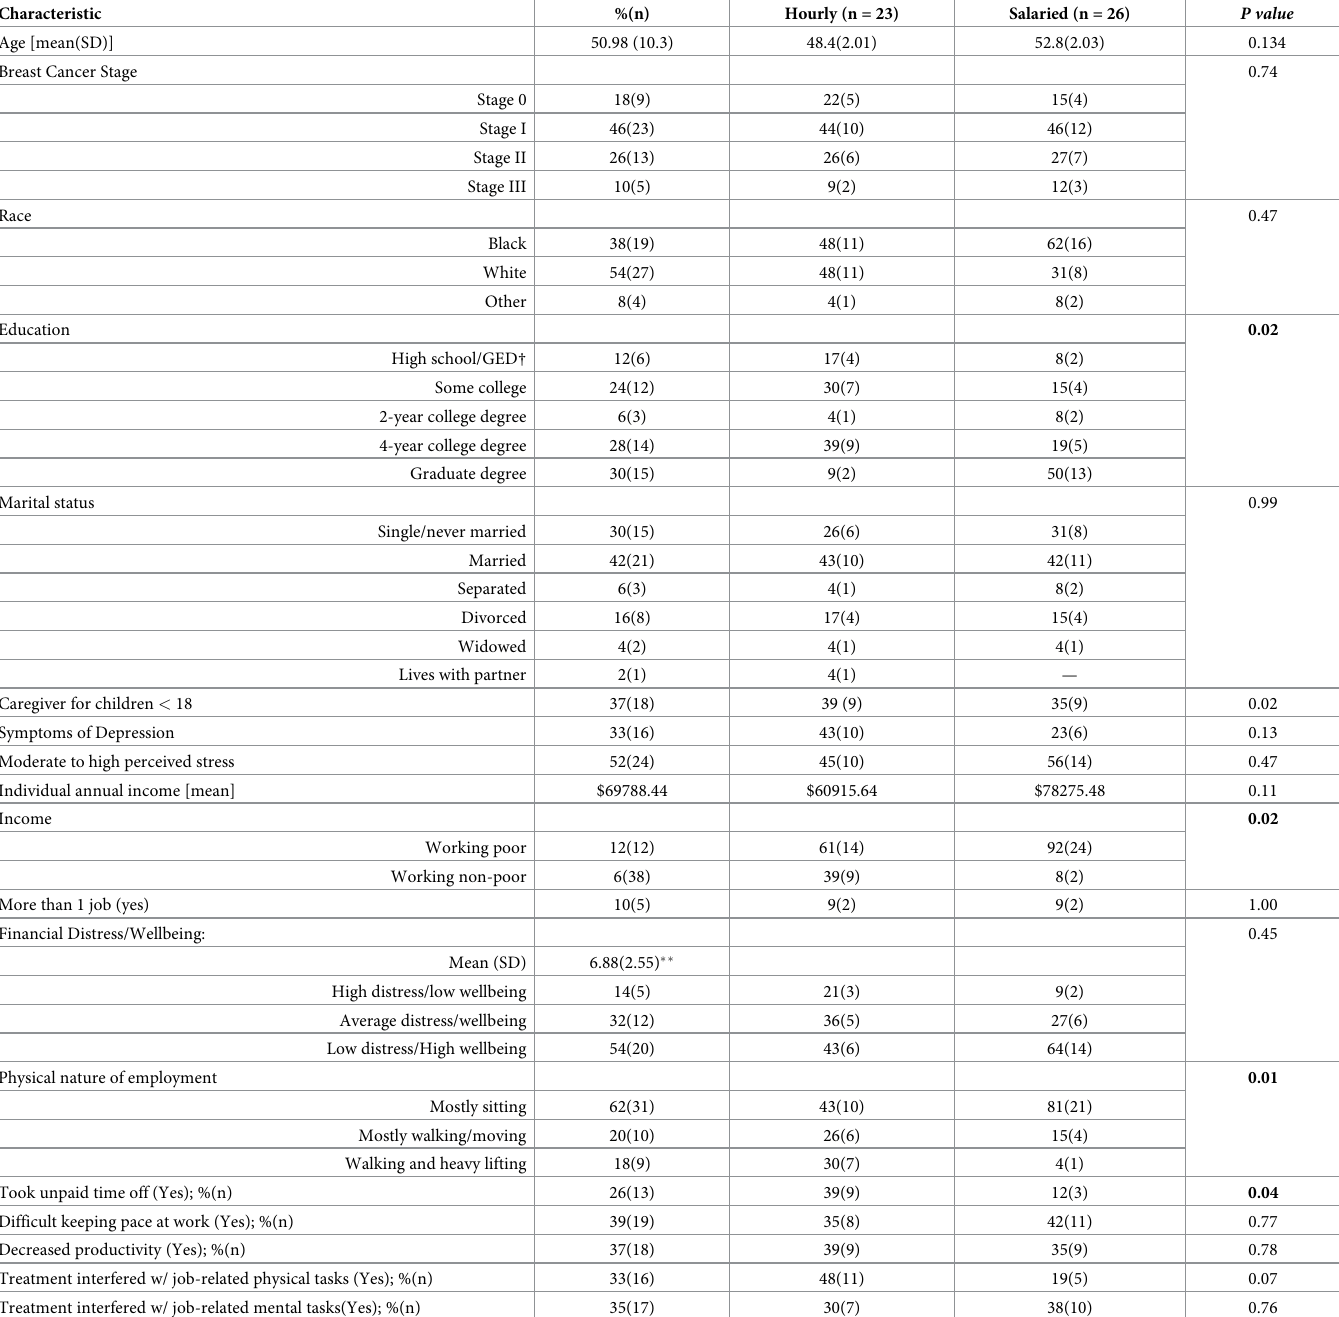
Table 2. Characteristics of EMPOWER participants at study enrollment/baseline (N = 50 �